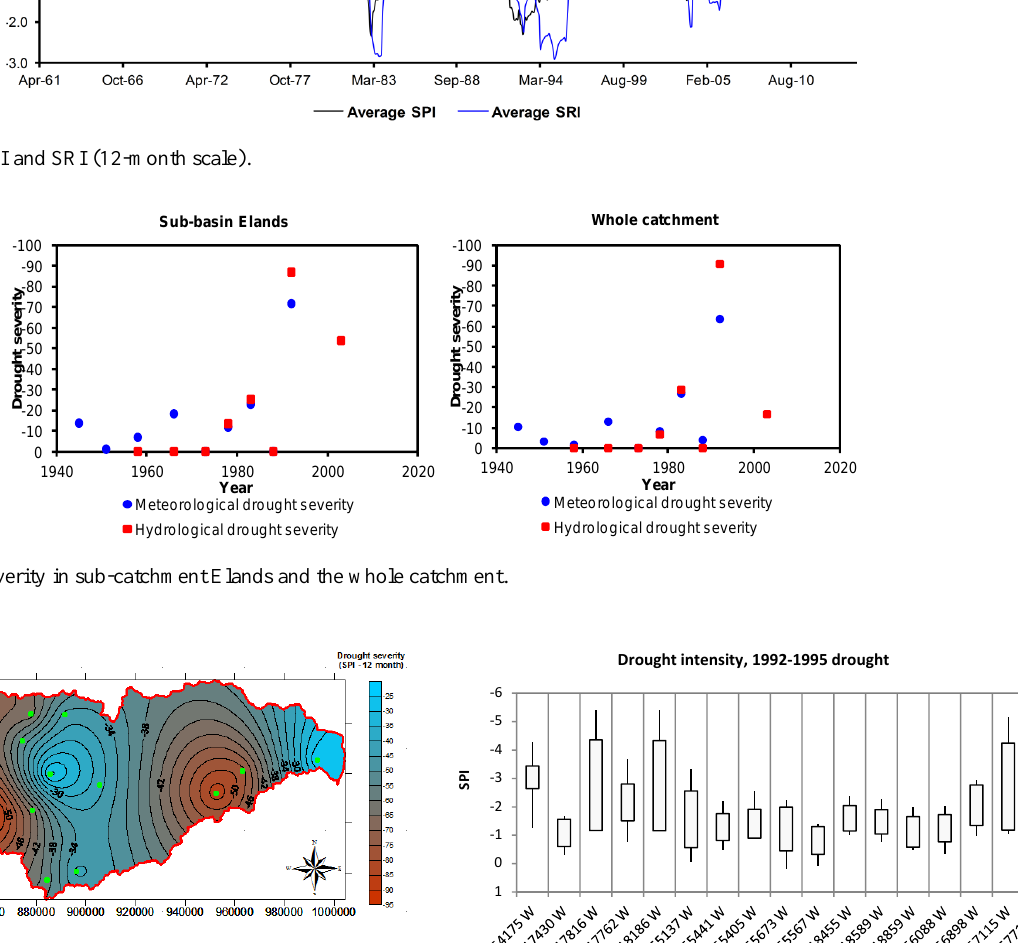
Figure 5. Distribution of the meteorological drought severity during the 1992–1995 drought.